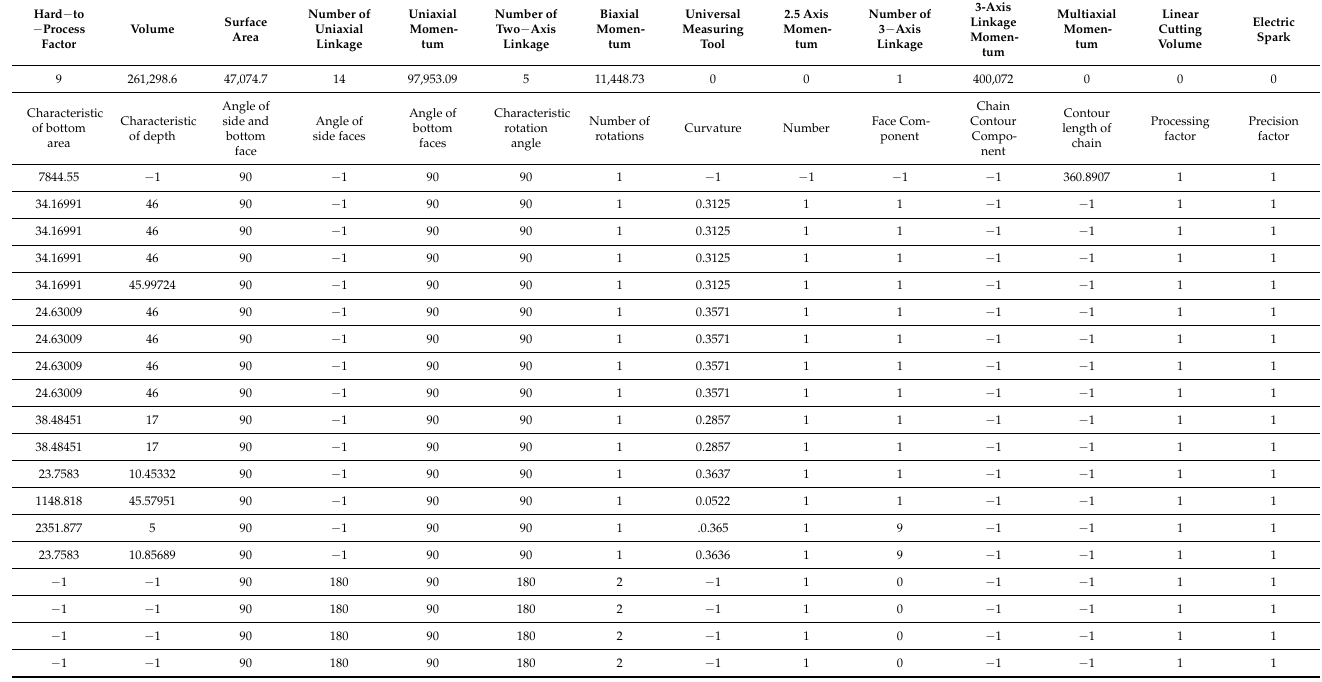
Table 8. The first half of the feature recognition results based on syntactic pattern